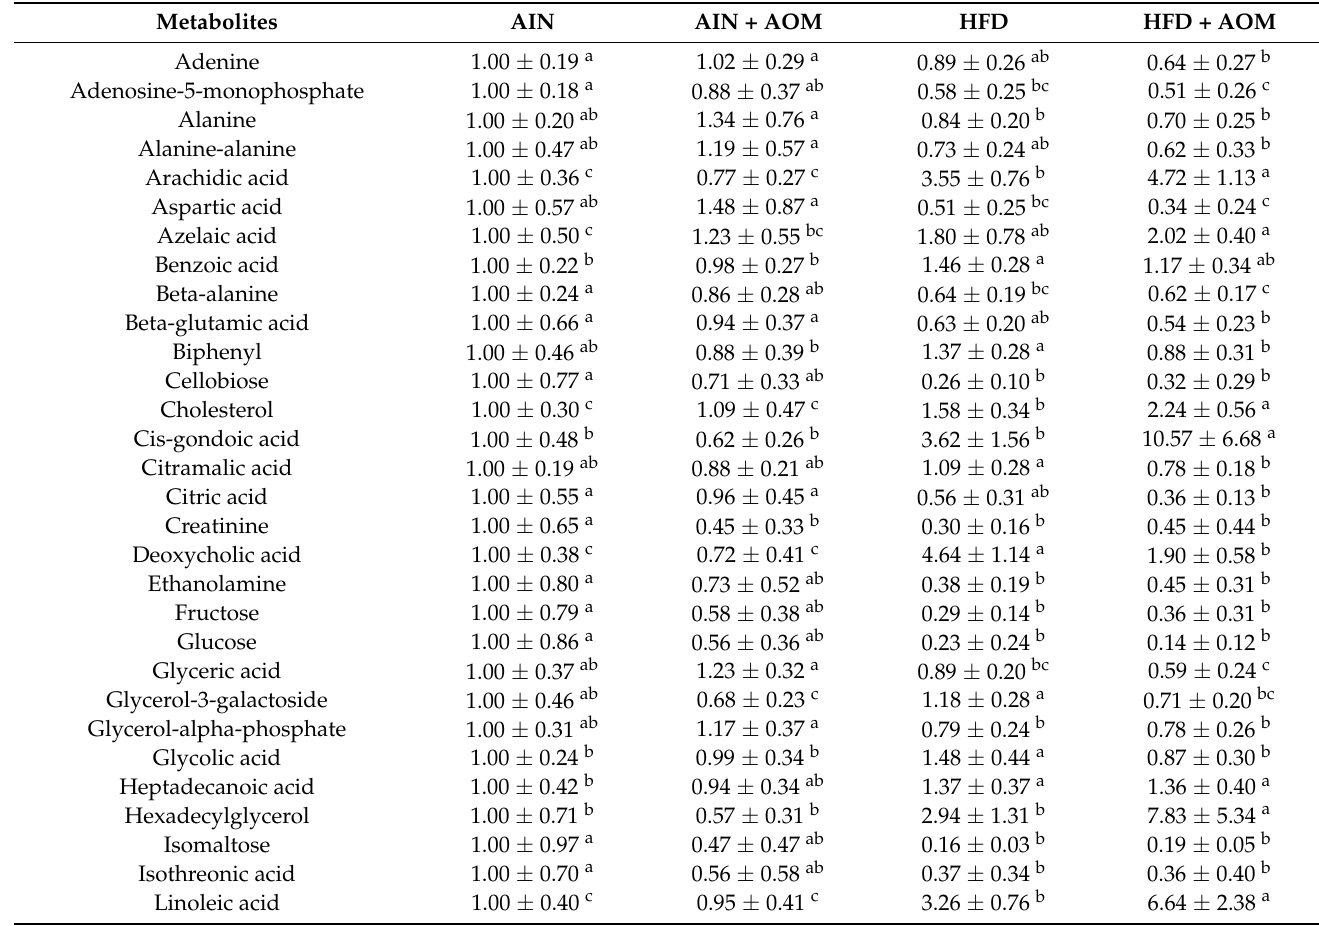
Table 1. The effect of AOM treatment and diet on the abundance of fecal